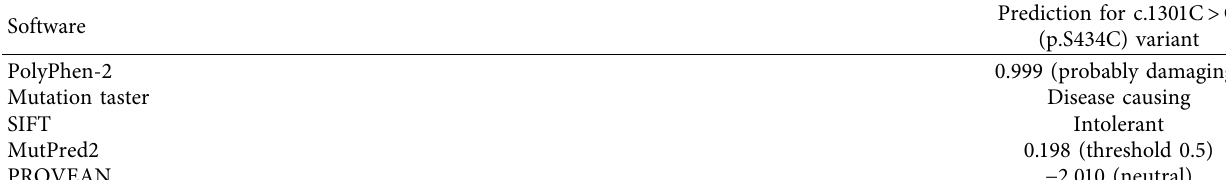
Table 1: In silico prediction tool results for c.1301 C > G (p.S434C) variant [8–12].